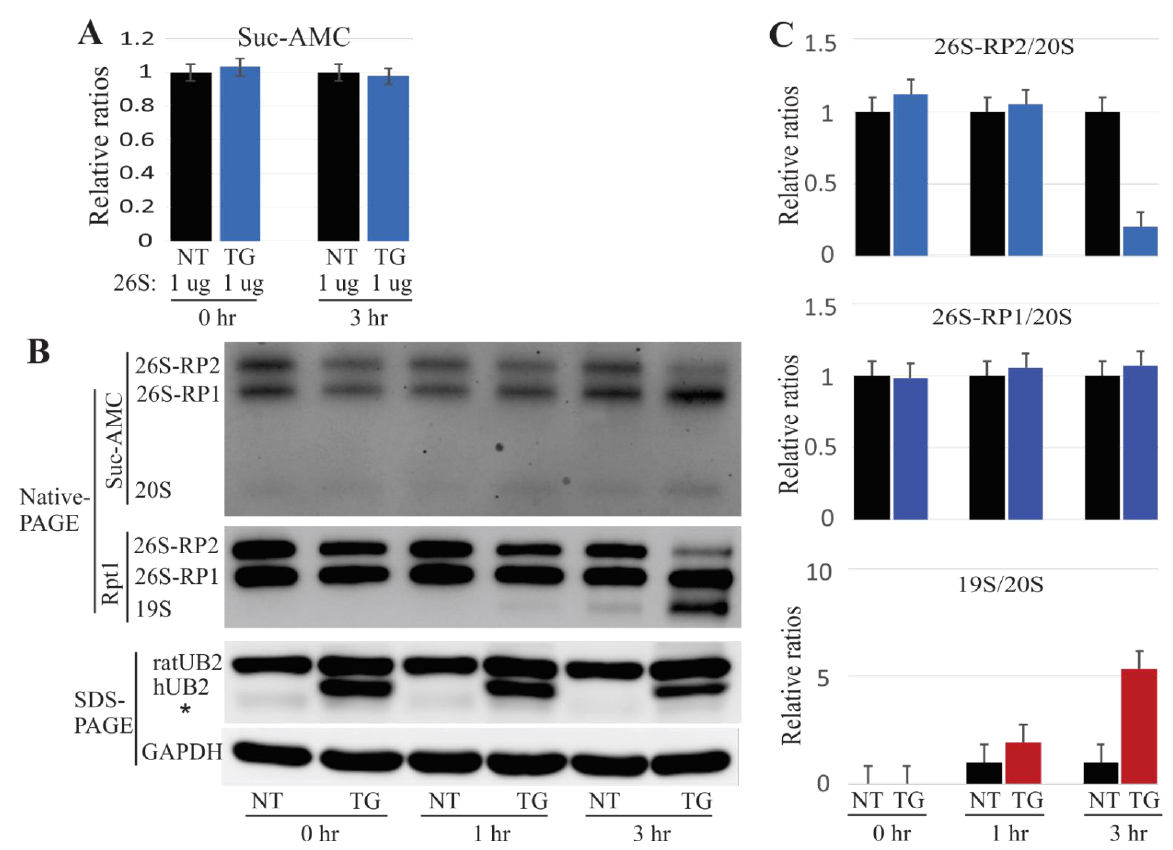
Figure 5. In vitro dissociation of the 26S proteasome by mutant UBQLN2. ( A ). The overall activity of proteasomes was measured using the sensitive fluorogenic substrate Suc-AMC. The data are reported as the mean ± standard deviation ( N = 3) and showed no significant difference. ( B ). Purified 26S proteasome was incubated with native protein lysates for the times (hr) indicated, followed by in-gel assay assessment using the proteasome substrate Suc-AMC and immunoblot analysis using indicated antibodies for either NativePAGE or SDS-PAGE. ( C ). Based on the Panel B data, the relative ratios of the 26S or the 19S to the 20S proteasome were calculated by Image-J software (the NT rat value was designated as 1). This analysis showed that mutant UBQLN2 led to reduction of 26S proteasome but a 19S proteasome increase. NT: non-transgenic rats; TG: mutant UBQLN2-P497H rats; 26S-RP1/26S-RP2: 26S containing one or two regulatory subunits.